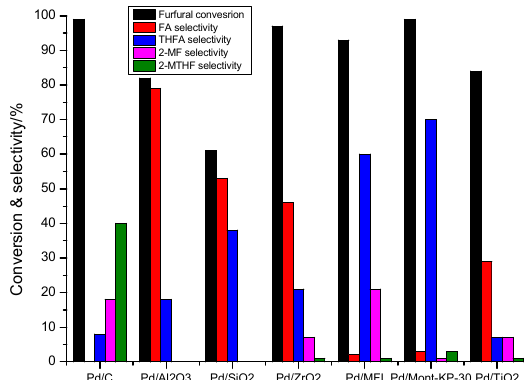
Figure 5. Pd based catalyst screening for hydrogenation of furfural with different supports. Adapted from Date et al. [167]. Reaction conditions: Furfural, 5 g; Solvent, Isopropyl alcohol (95 g); Temperature, 220 °C; Pressure, 500 psi; Agitation Speed, 1000 rpm, Catalyst, 4% metal loading; loading, 0.5 g; Reaction time, 5 h.